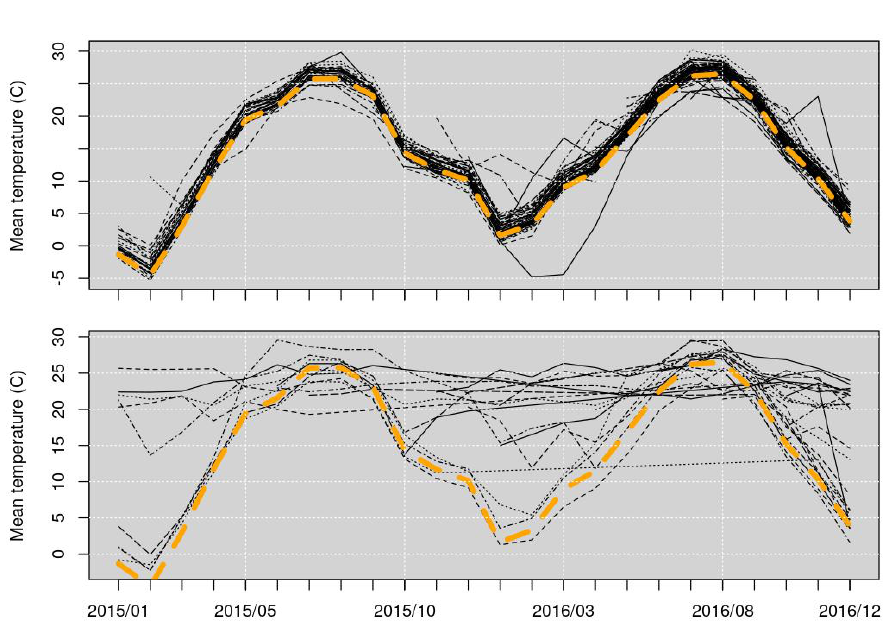
Figure 2. WU data quality control—Mean temperature of PWSs. In both the graphs, the black lines represent the mean temperatures of the PWSs, while the dashed yellow line represents the mean temperature of the four METARs stations. The upper graph shows the stations represented with the green points in Figure 1 (mean within the threshold); while the lower graph shows the stations represented with the red points in Figure 1 (mean higher than the threshold).